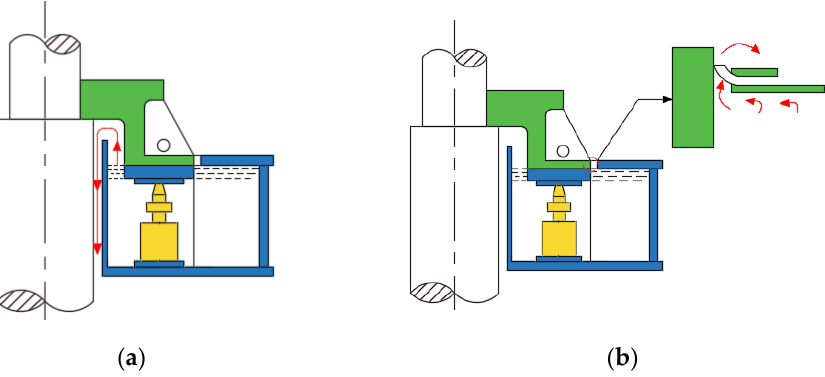
Figure 3. Schematic diagram of internal and outside oil throwing (modified according to reference [41]). ( a ) Internal oil throwing; ( b ) external oil